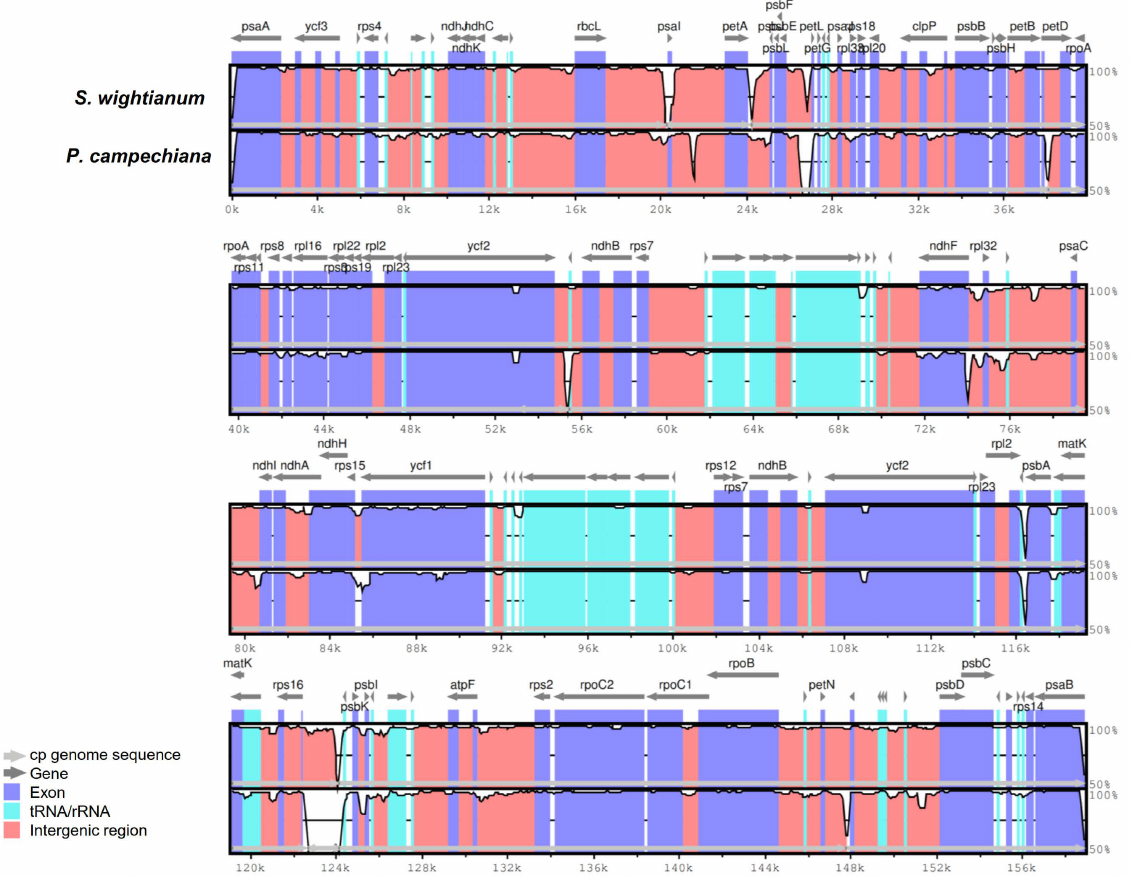
Figure 3. mVISTA percent identity plot comparing the three Sapotaceae plastid genomes with A. spinosa as a reference. The top line shows genes in order (transcriptional direction indicated by arrows). The y-axis represents the percent identity within 50–100%. The x-axis represents the coordinate in the chloroplast genome. Genome regions are color-coded as protein-coding (exon), tRNAs or rRNAs, and conserved noncoding sequences (intergenic region). The white block represents regions with sequence variation between the two